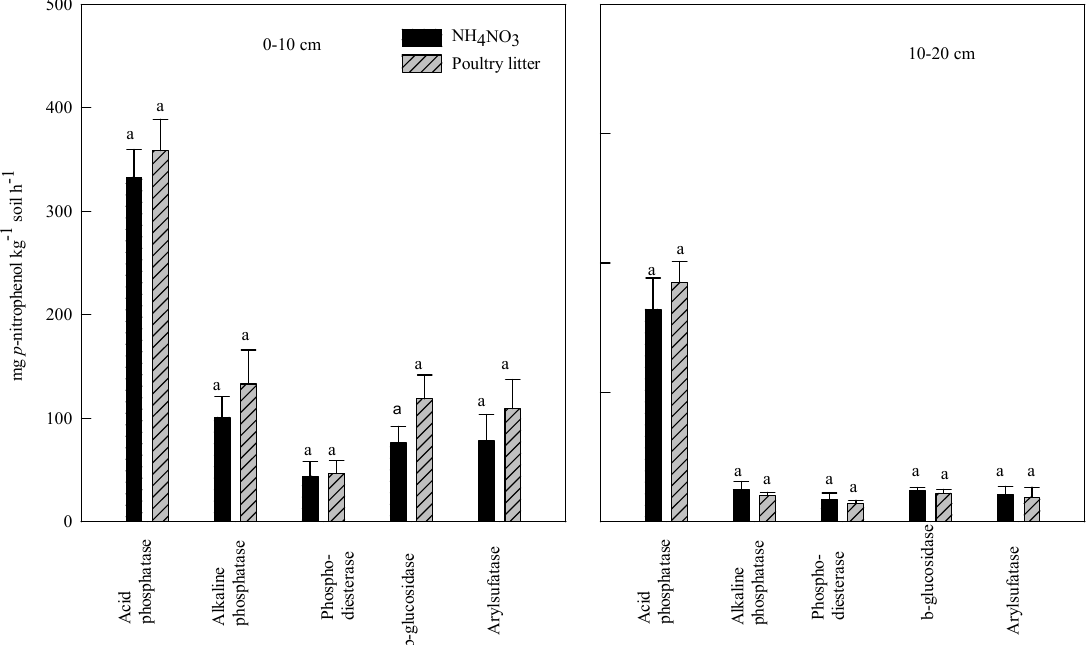
Figure 3. Effect of poultry litter and ammonium nitrate on average values of selected enzyme activities at two soil sampling depths. The bars with different letters within enzyme activity are significantly different ( P <